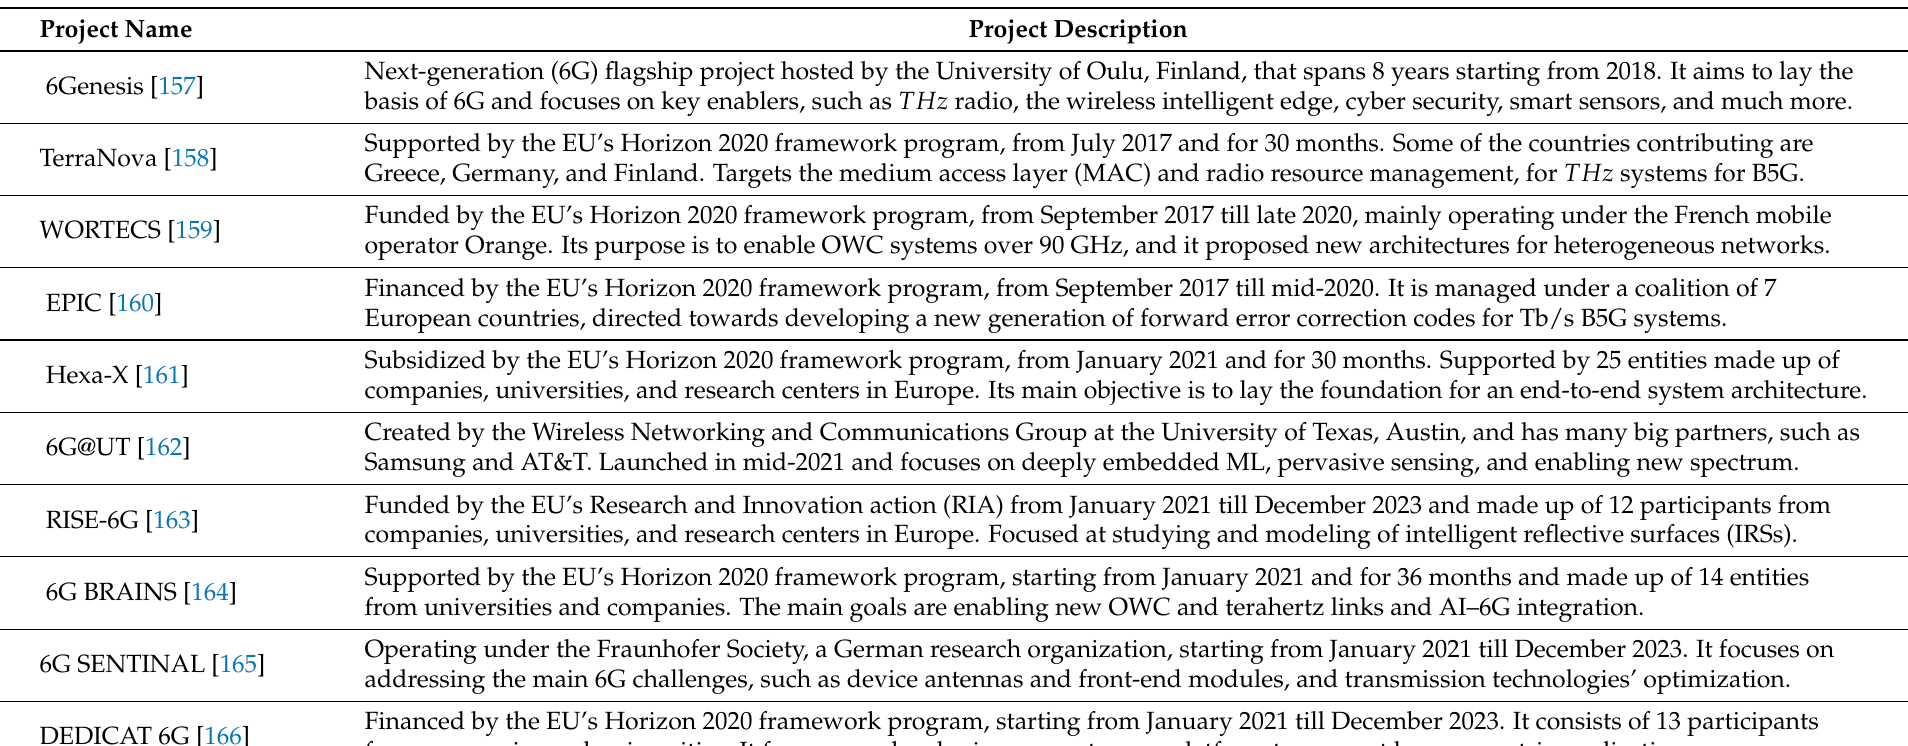
Table 5. A short description of some of the projects dedicated to B5G/6G research